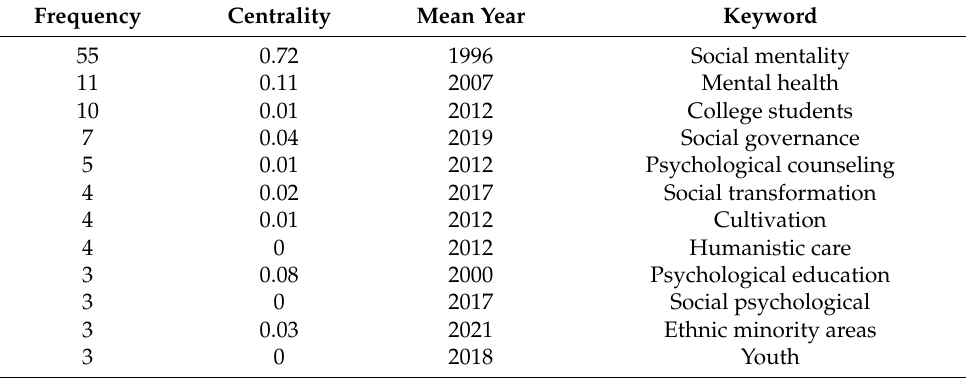
Figure 3. Time zone diagram of keywords on social mentality and health in the CNKI database before 1 April 2022 by keyword co-occurrence analysis via CiteSpace software (generated by the authors). The interpreted English words and phrases are in line with the original Chinese words and phrases in CiteSpace software. Table 1. Statistics of keyword frequency in TOP 12 keywords on social mentality and health in the CNKI database before 1 April 2022 by keyword co-occurrence analysis via CiteSpace software (generated by the